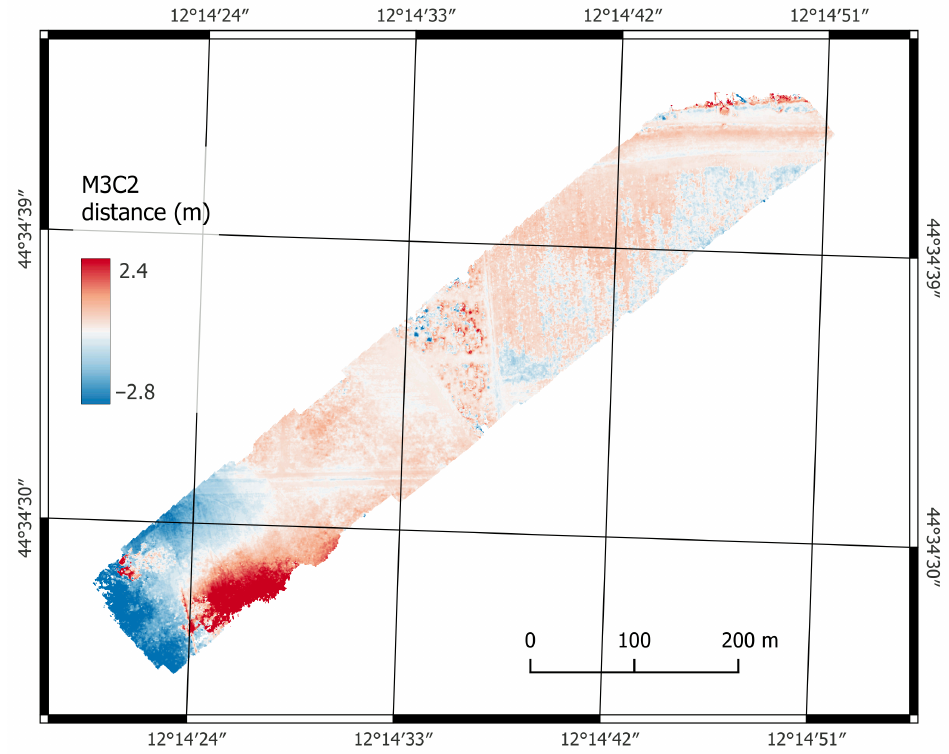
Figure 9. M3C2 distance map between the point clouds generated by thermal and visible images, respectively, for S07 survey.